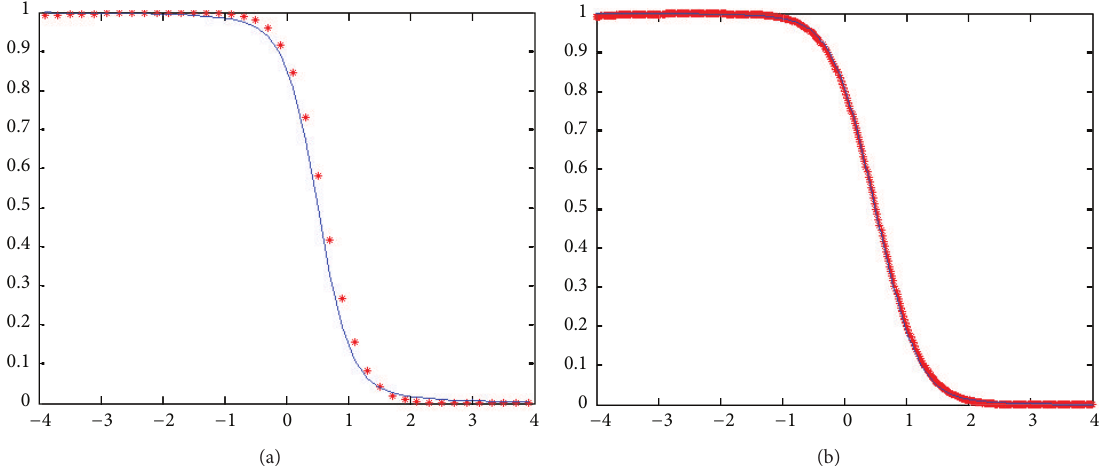
Figure 5: Numerical solution (red line) of the method (26)-(27) and the exact solution (blue line) for the FADE with 𝜔 = 1.6 . The graphic to the left shows the results for Δ𝑥 = 0.2 and the graphic to the right shows the results for Δ𝑥 = 0.02